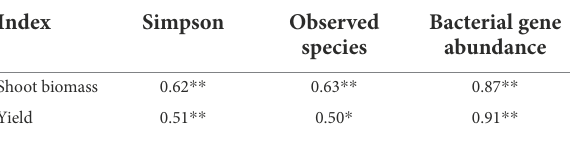
TABLE 2 The correlations of bacteria α -diversity and gene abundance with biomass and wheat